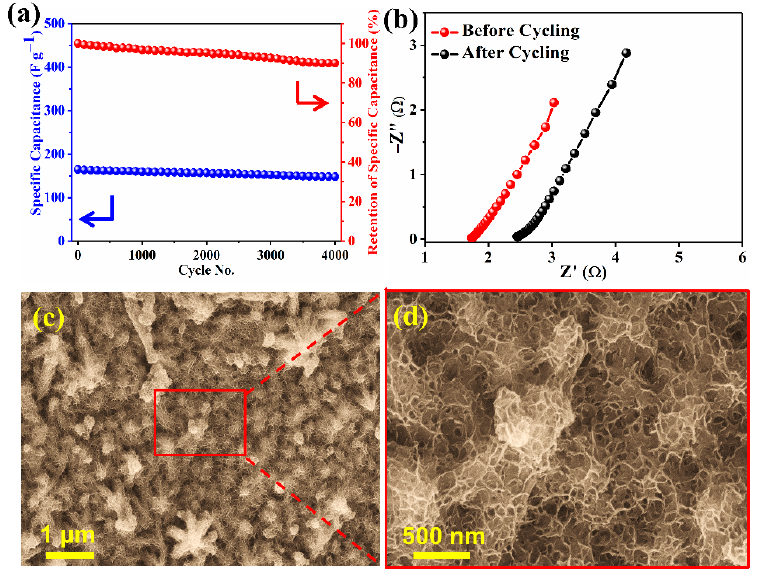
Figure 10. ( a ) Galvanostatic charge-discharge cycling performance at the current density of 15 A g − 1 and ( b ) Nyquist plot before and after cycling; ( c , d ) SEM images at different magnifications, taken after 4000 cycles; all for NCMSM in 1 M